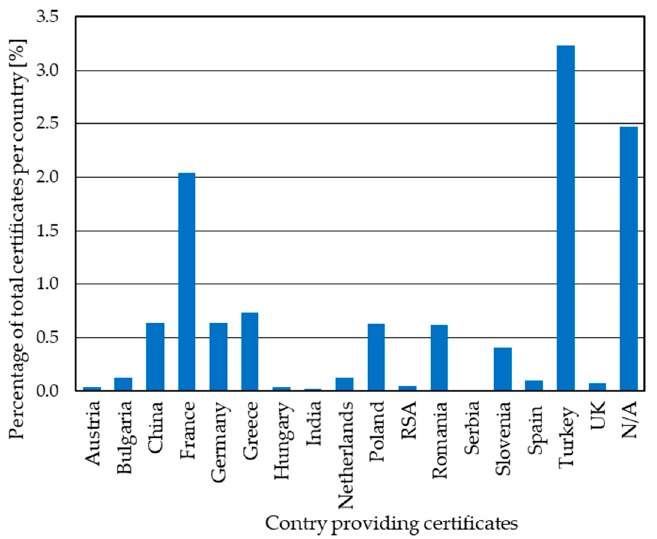
Figure 2. Distribution of obtained material test certificates (tensile test results) by country excluding Norway and Italy.